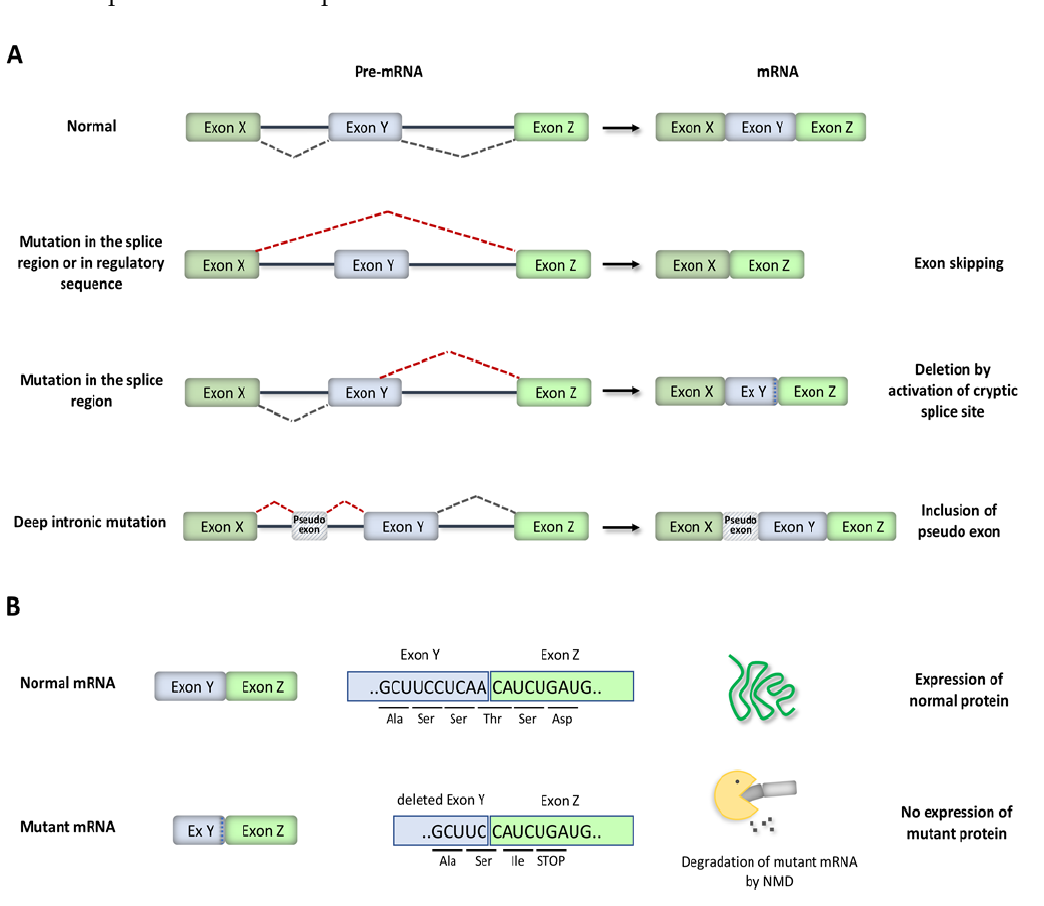
Figure 4. Splicing mutations. ( A ) Schematics illustrating the consequences of cis -acting mutations on pre-mRNA splicing. ( B ) Representation of a frameshift deletion introduced by the activation of a cryptic splice site within an exon and degradation of the resulting mRNA by nonsense-mediated decay (NMD). A second category of mutations disrupts exonic splicing regulatory elements (Figure